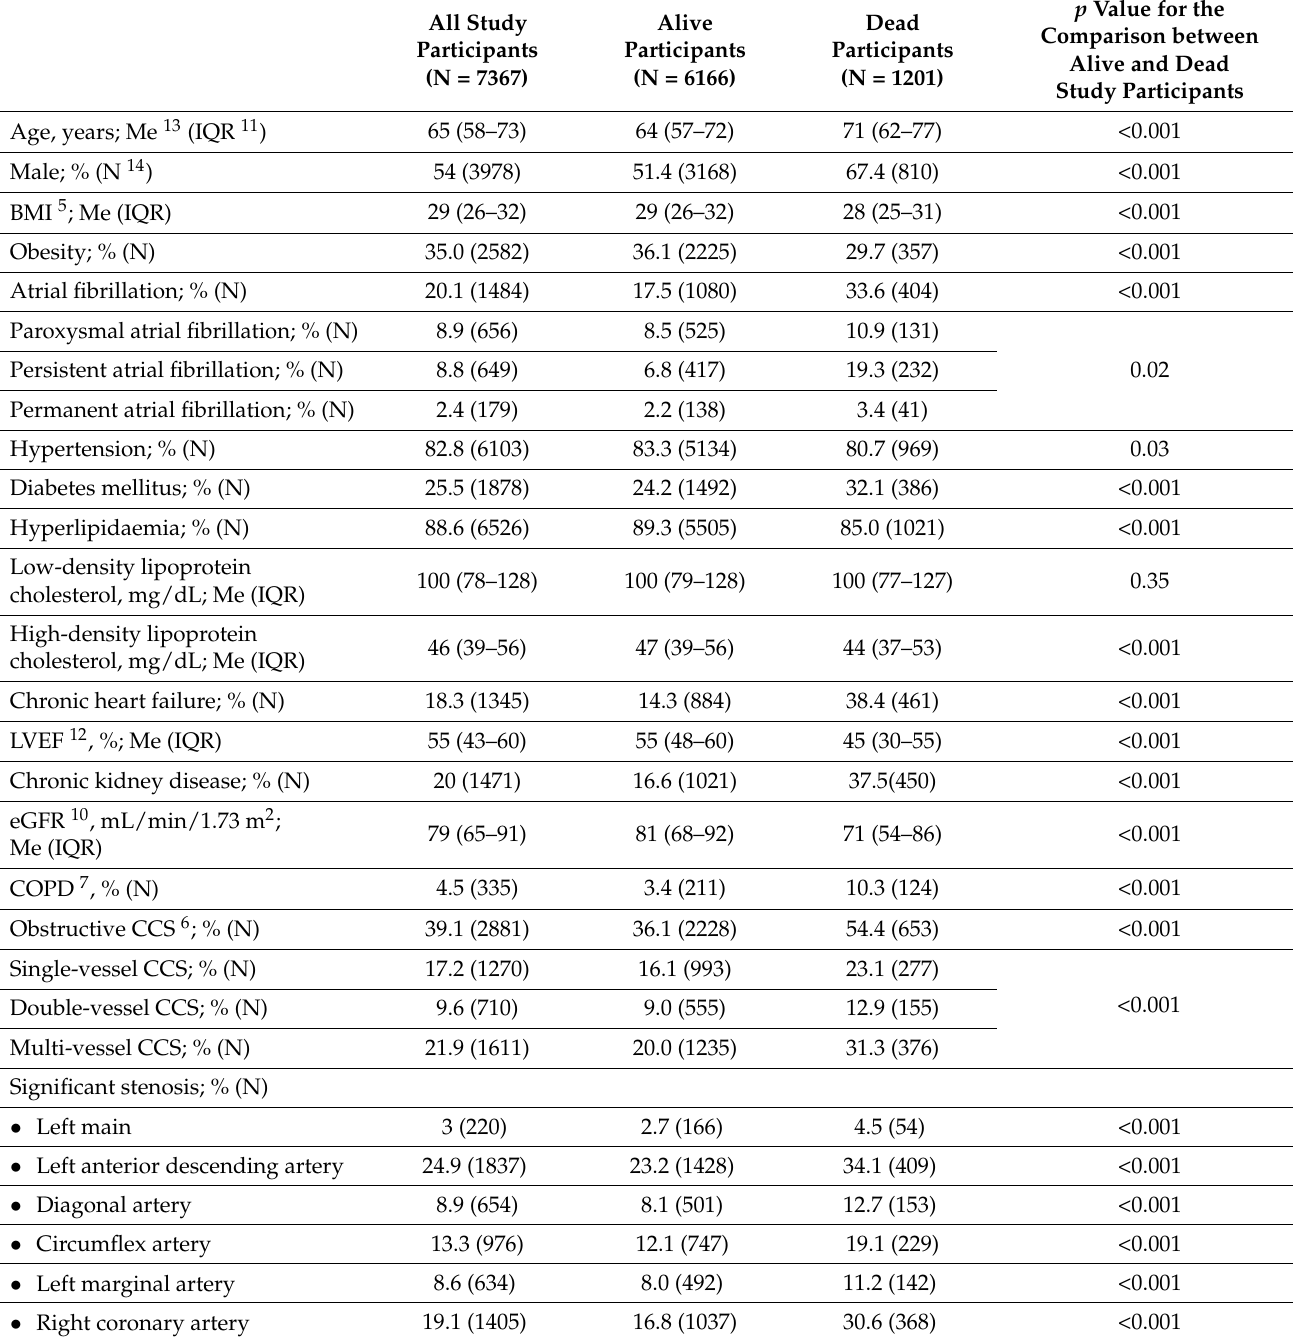
Table 1. Baseline characteristics in the whole cohort, and alive and dead participants at follow-up.